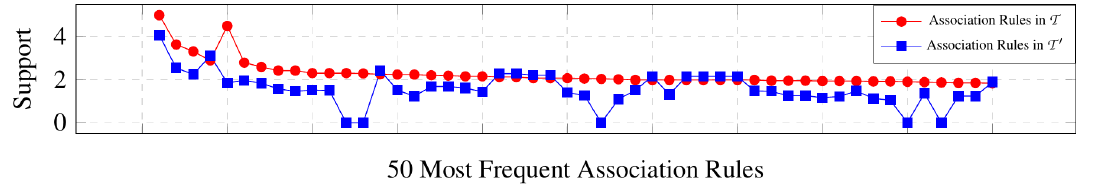
Figure 6. Frequent association rules mining (support ≥